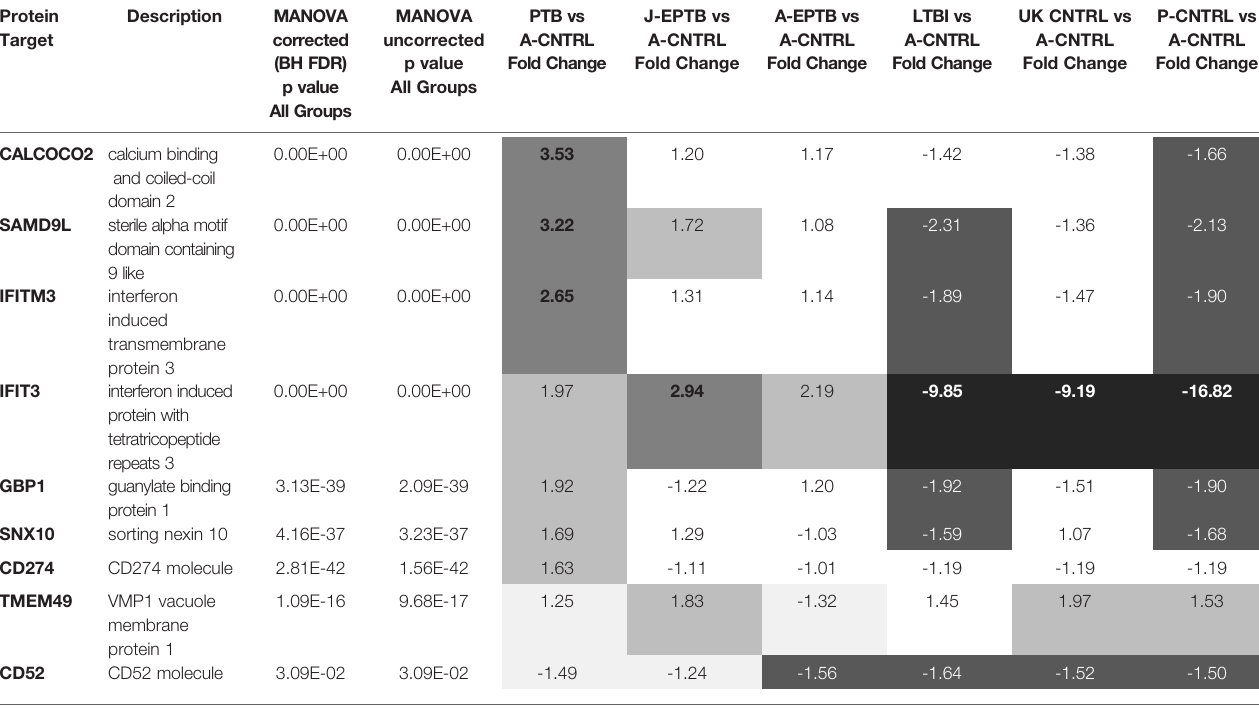
TABLE 2 | p-values from MANOVA analysis and fold-change data (using the A-CNTRL group as baseline control) across all biomarkers and groups fold-change ≥ 2.5, fold-change ≥